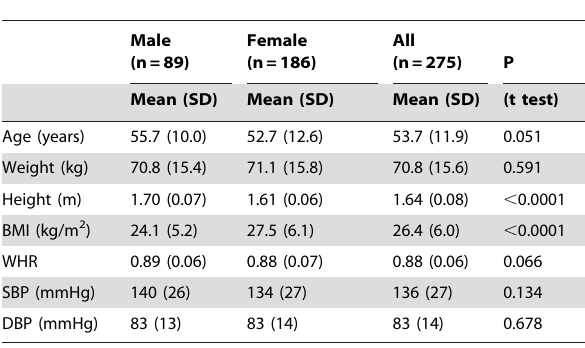
Table 1. The clinical characteristics of participants by sex.